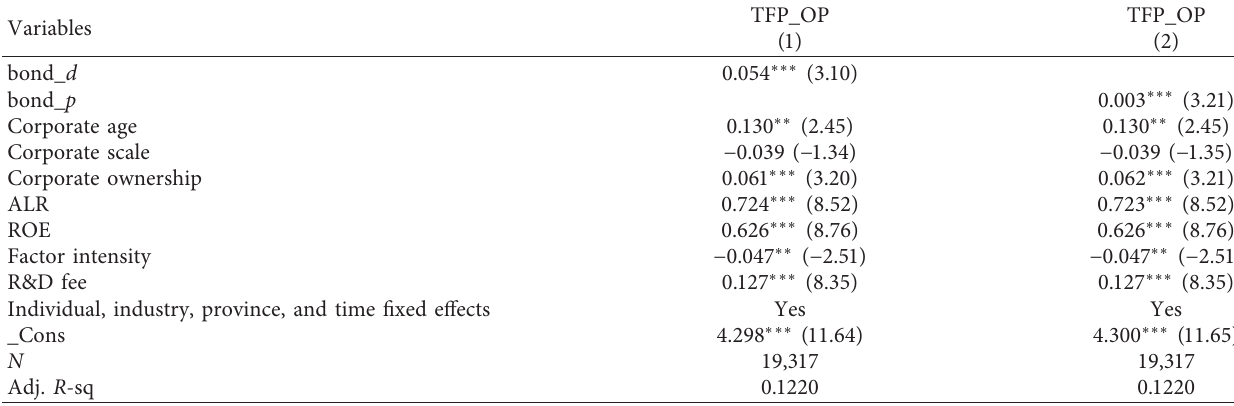
Table 2: Regression results on bond financing and corporate TFP.